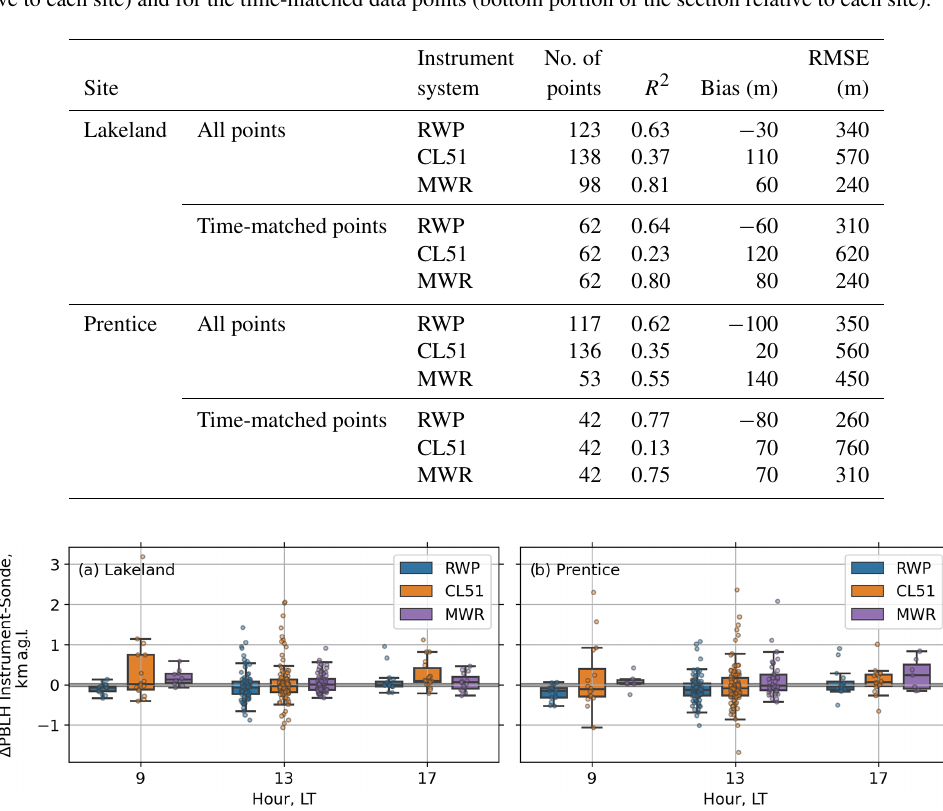
Table 3. Statistical comparison of PBLH estimated by the RWPs, CL51s, and MWRs compared with the radiosonde estimates during the entire CHEESEHEAD19 campaign for the Lakeland and Prentice sites. Results are presented for all available data points (upper portion of the section relative to each site) and for the time-matched data points (bottom portion of the section relative to each site).